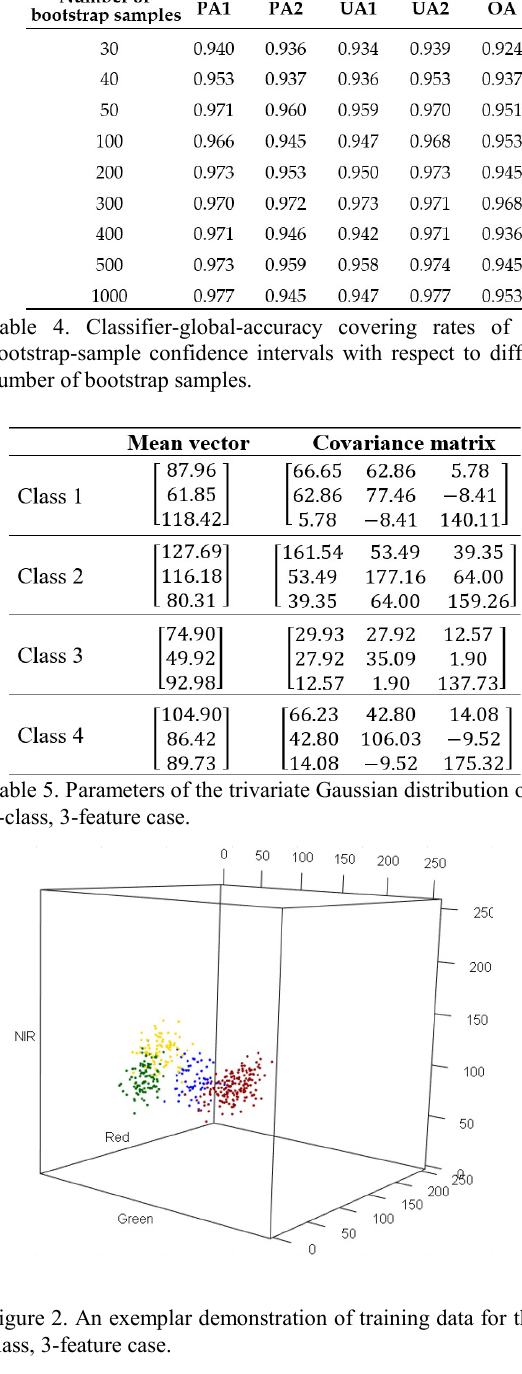
Figure 3. Illustration of 95% bootstrap confidence intervals for the 4-class, 3-feature case